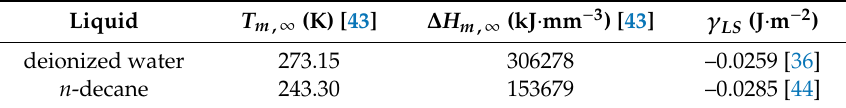
Table 2. Thermodynamic characteristics used in model calculations.